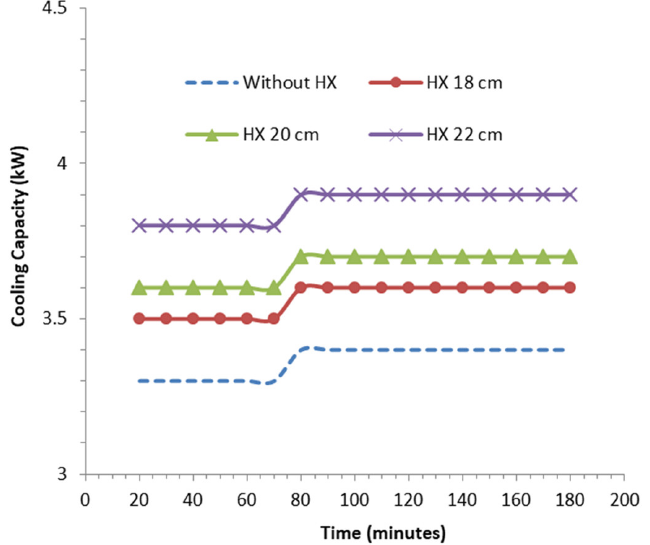
Figure 6. Cooling capacities of A/C using condensate water as a subcooler for three different lengths of heat exchangers.